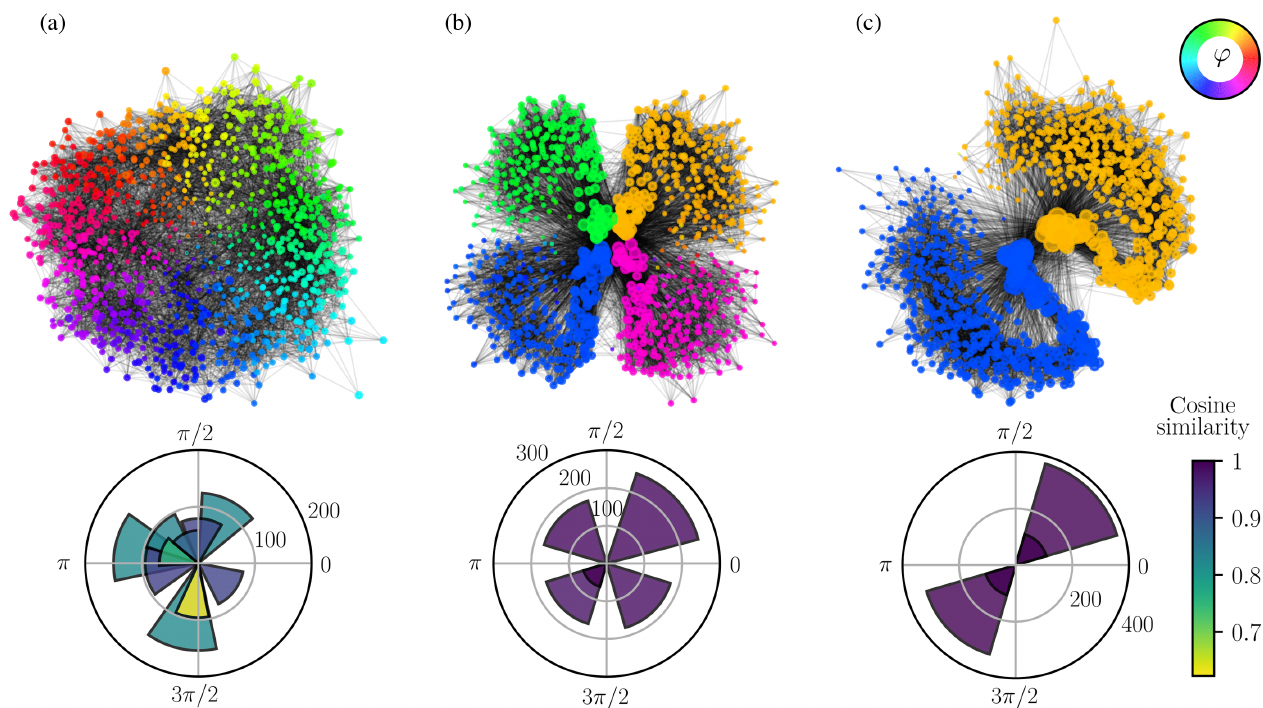
FIG. 5. Community structure of the social networks. Visualization of the social networks aggregated over the last 70 time steps (top) and corresponding community detection (bottom) for three different dynamical regimes: (approaching) consensus (a), uncorrelated polarized state (b), and ideological state (c). The model parameters are set as in Figs. 2(a) – 2(c), i.e., α ¼ 0 . 05 , δ ¼ π = 2 (a), α ¼ 3 , δ ¼ π = 2 (b), and α ¼ 3 , δ ¼ π = 4 (c). Top: In the network illustrations, each node is colored according to its opinion angle φ , and its size is proportional to its conviction r . Bottom: Communities are represented in the polar bar plot below each network. Each community is represented by a bar: The radius represents the size, and color and width correspond to the average cosine similarity between all pairs of agents within the community. The orientation represents the average opinion angle h φ i of all agents within the community. Communities containing less than 5% of the total number of nodes are not